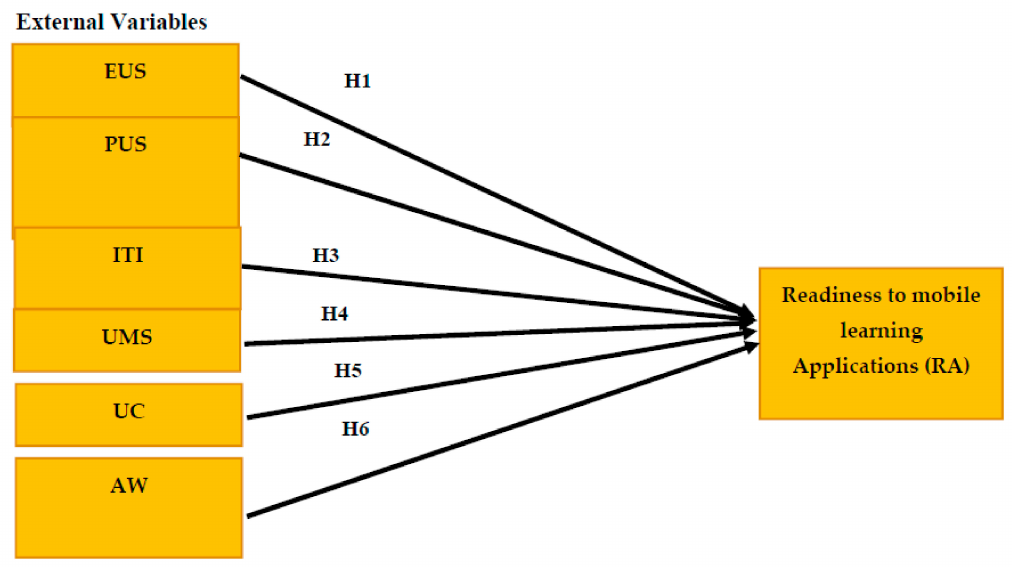
Figure 3. The proposed model for explaining the readiness of mobile learning.